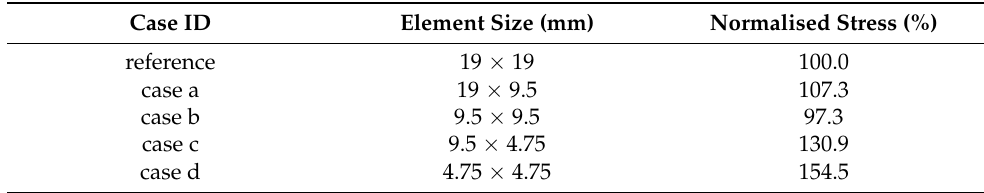
Table 1. Maximum normalized stress vs. mesh refinement level; normalization reference: maximum stress computed on the standard reference load (RL) distribution reported in Figure 4.